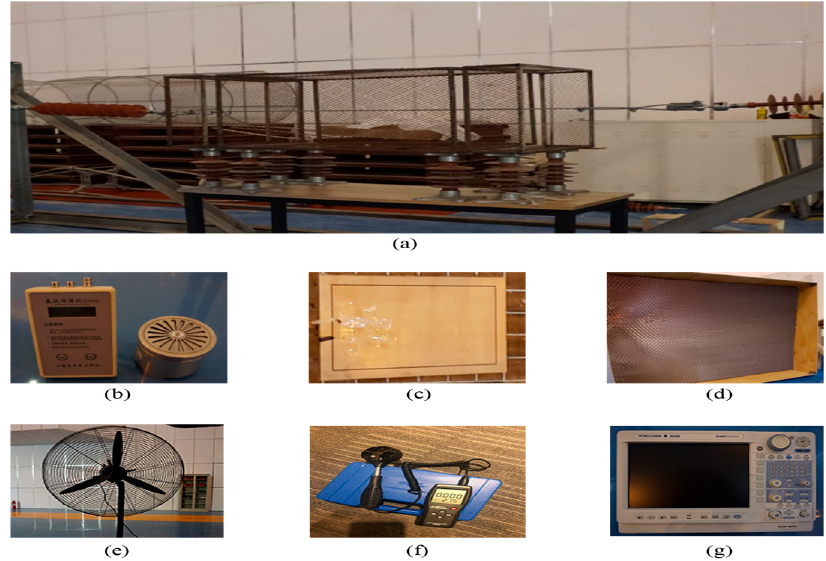
Figure 8. ( a ) The general view of the corona cage; ( b ) The electric field mill; ( c ) The Wilson plate; ( d ) Flow equalizing plate; ( e ) adjustable speed fan; ( f ) digital high precision anemometer; and ( g ) scope